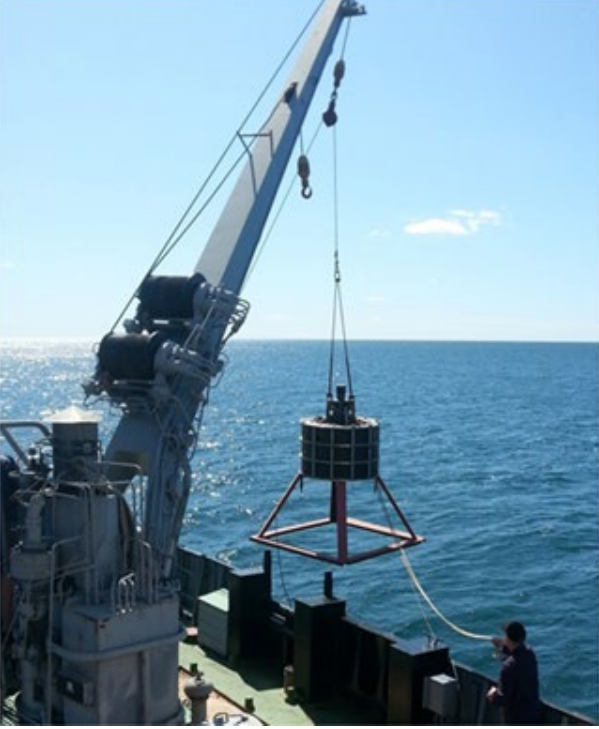
Figure 2. Broadband hydroacoustic source consisting of three piezoceramic rings.